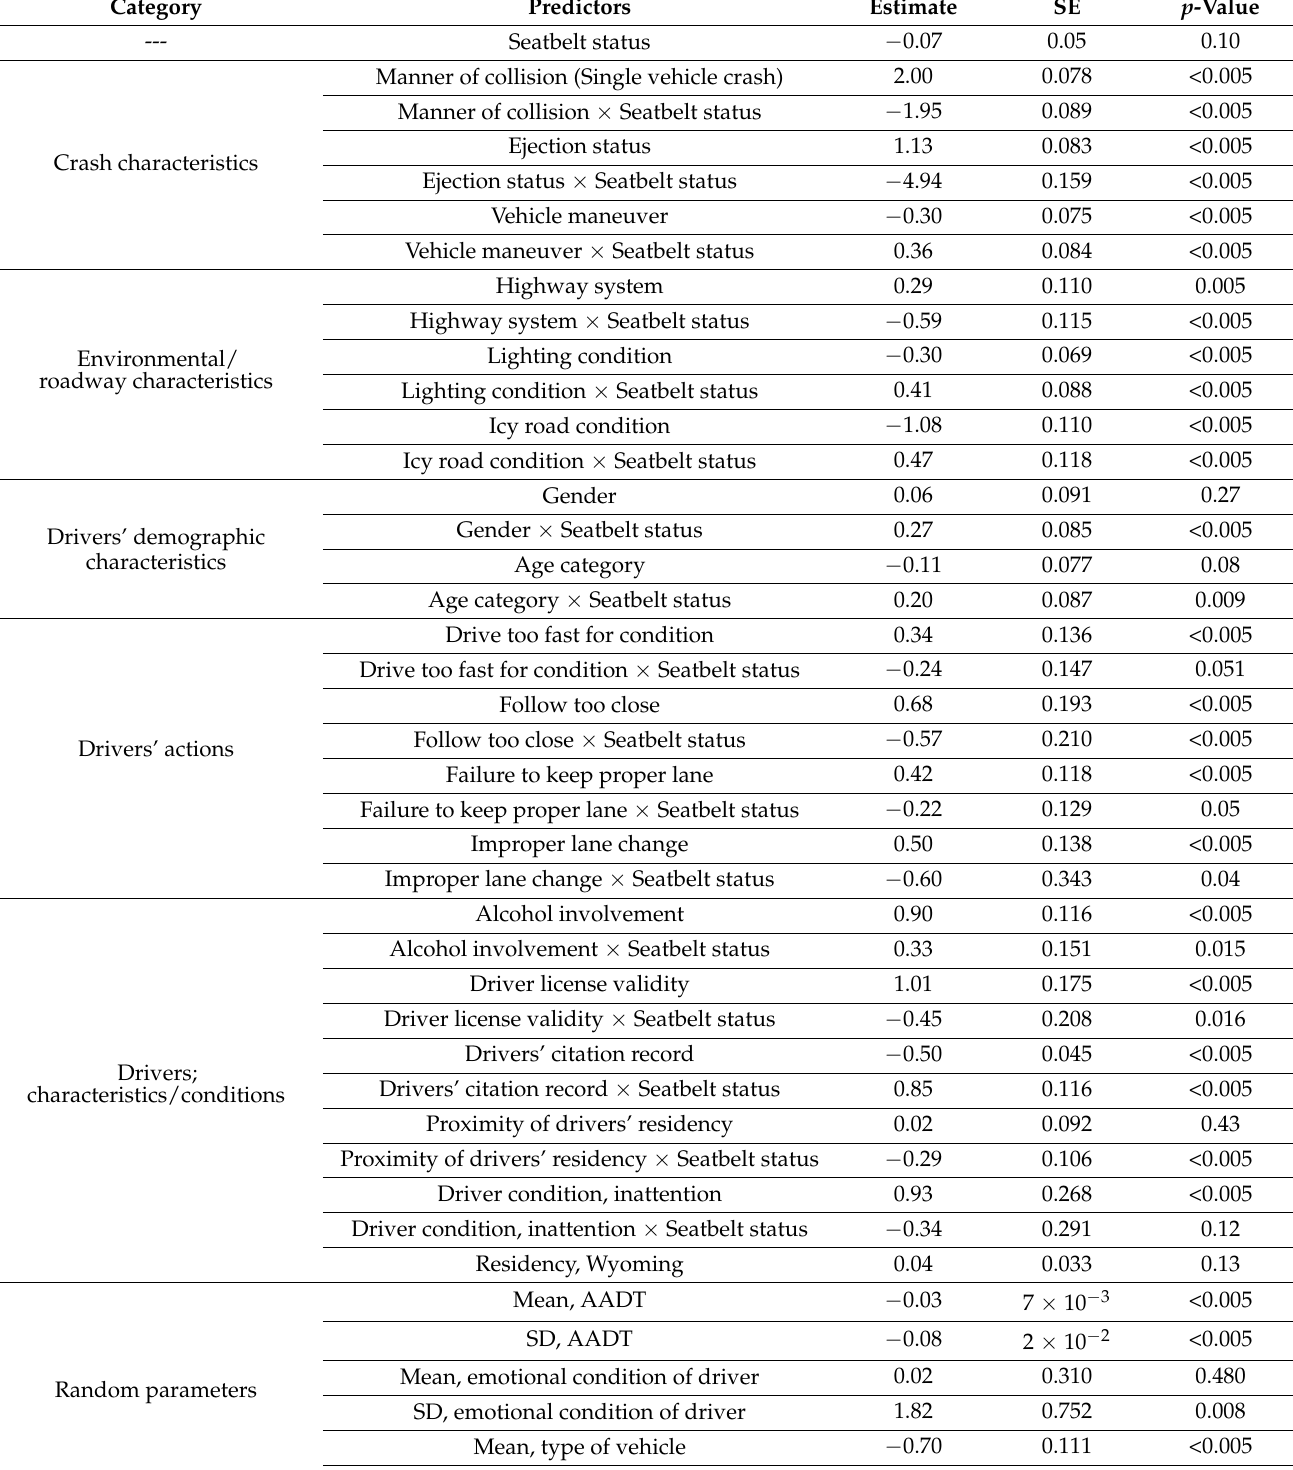
Table 2. Results of the mixed model, considering all interaction terms of seatbelt